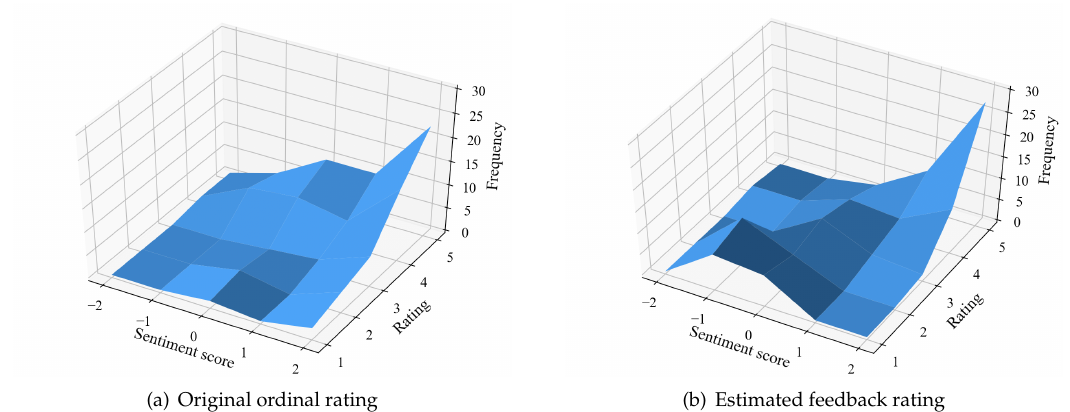
Figure 10. Surface plots illustrating the frequencies of user feedback logs according to the sentiment scores of review texts ( x -axis) and the ( a ) original ordinal ratings or ( b ) estimated feedback ratings ( y -axis).